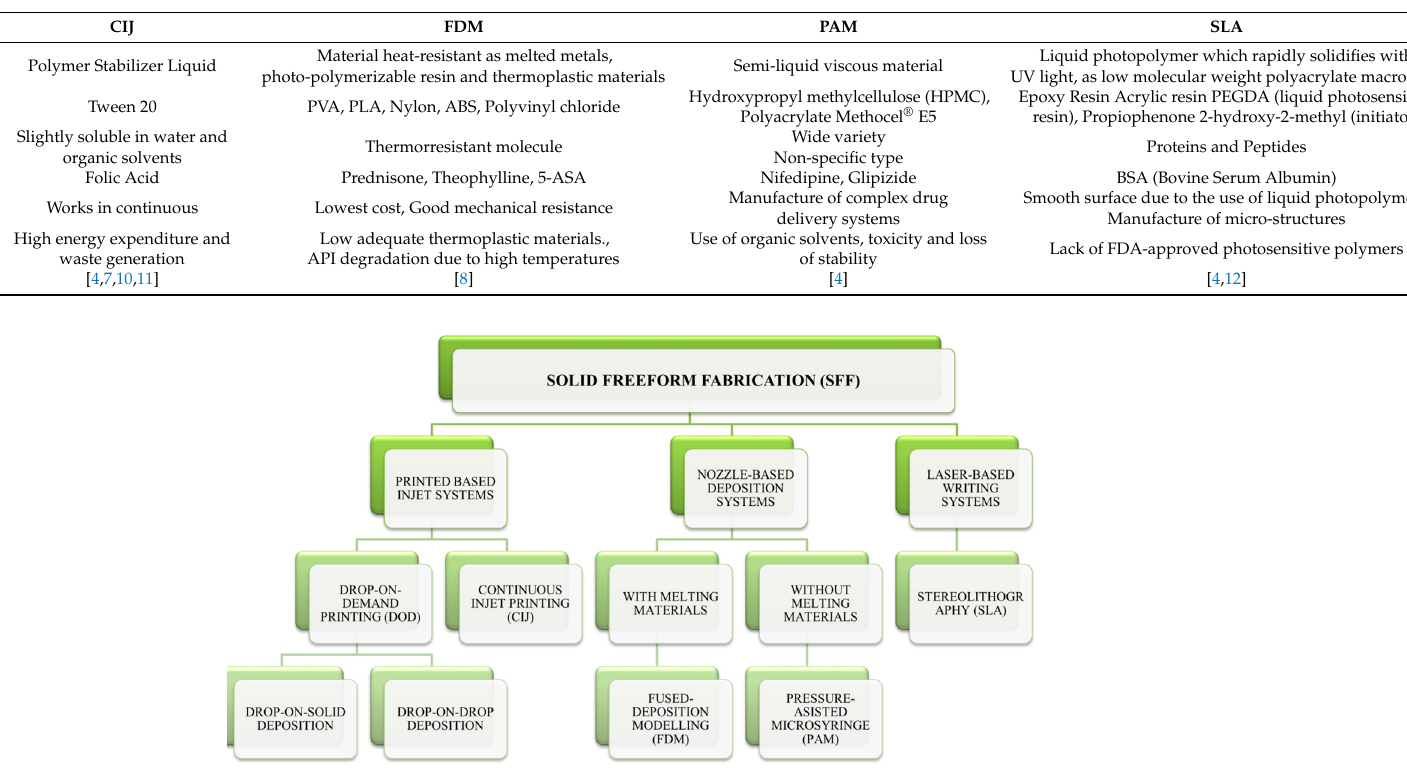
Table 1. Comparison of three-dimensional (3D) Printing Techniques.